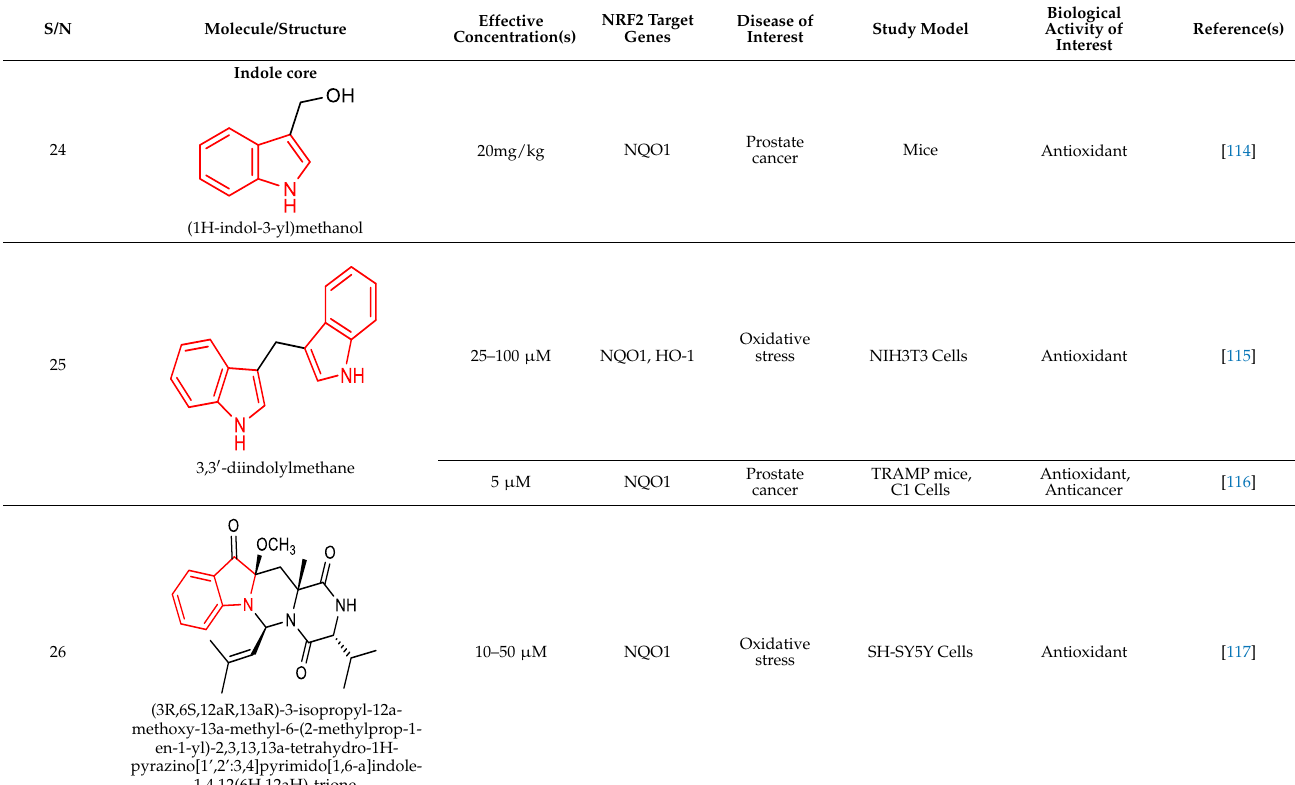
Table 2. Fused Nitrogen heterocyclic compounds and NRF2-inducing activities.